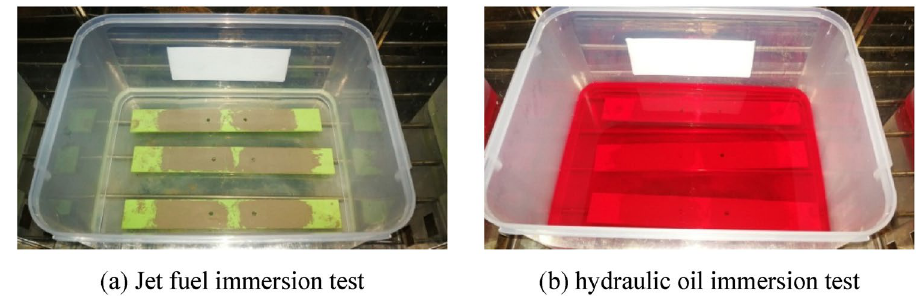
Figure 17. Fluid immersion experiment.